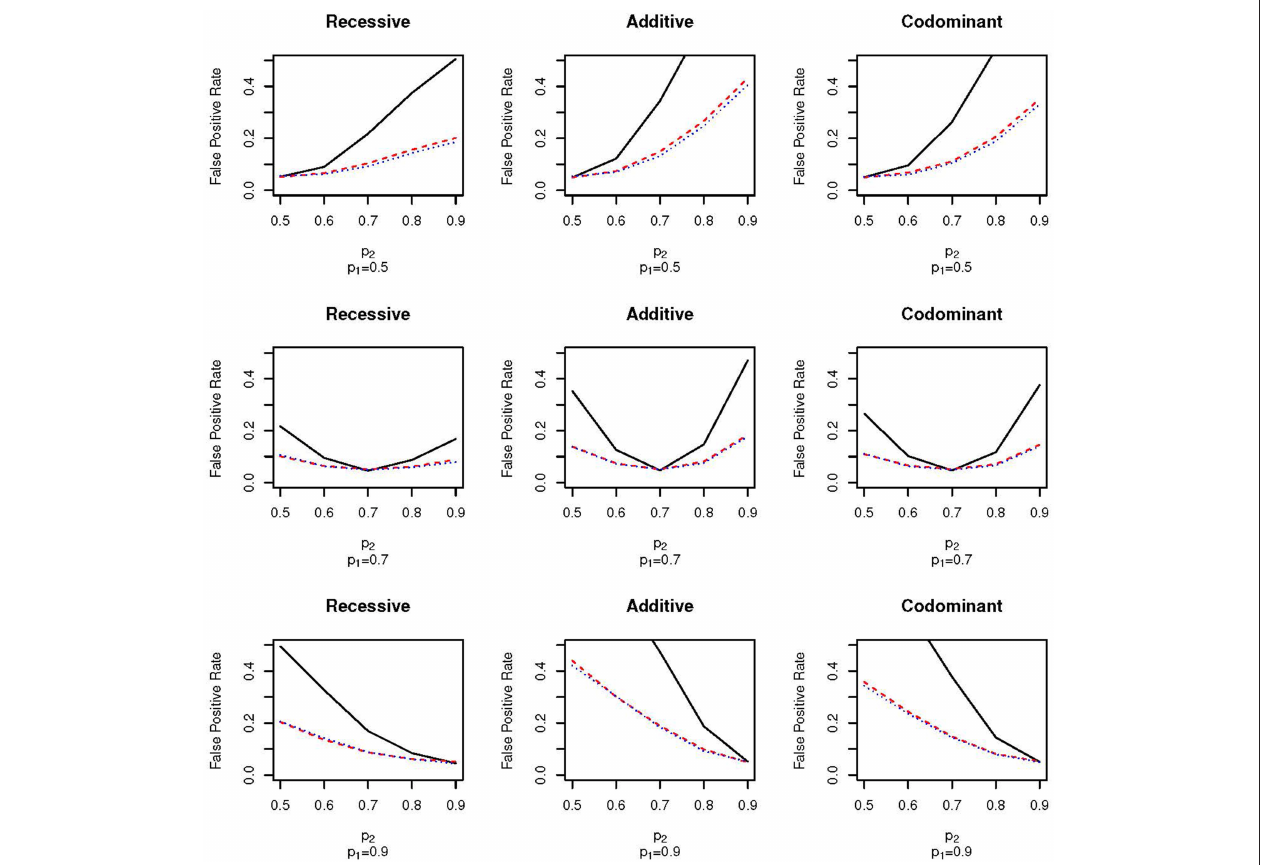
FIGURE 2 | False positive proportion for scenarios with ω 1 = 0.5 and µ = 0.1. The solid, black line gives the false positive rate under EPS. The dashed, red line gives the false positive rate under random sampling. The dotted, blue line gives the rate under case-control sampling. The first column corresponds to the recessive test, the second column corresponds to the additive test and the third column corresponds do the codominant test. The first row corresponds to simulations with p 1 = 0.5, the second row corresponds to simulations with p 1 = 0.7 and the third row corresponds to simulations with p 1 = 0.9. TABLE 2 | Estimated false positive proportions using parameter settings from Italy and France data. Population proportion EPS Random sampling Italy France Recessive Additive Codominant Recessive Additive